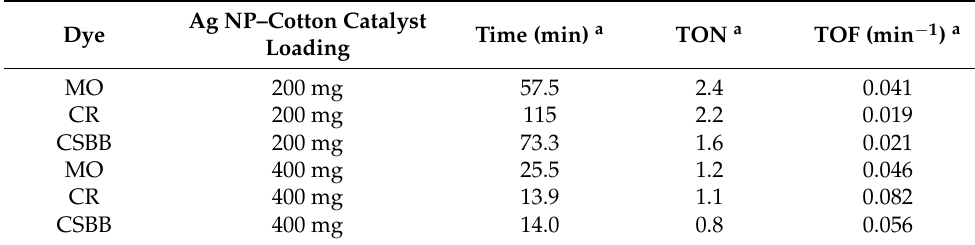
Table 2. Calculated turnover number (TON) and turnover frequency (TOF) for catalytic dye degrada- tion studies using 200 and 400 mg Ag NP–cotton catalyst loading.